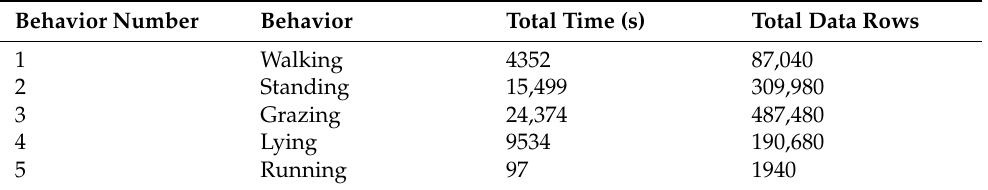
Table 3. The total time and data size of observations available for each behavior. A row comprises an x -, y - and z -axis accelerometer and gyroscope raw